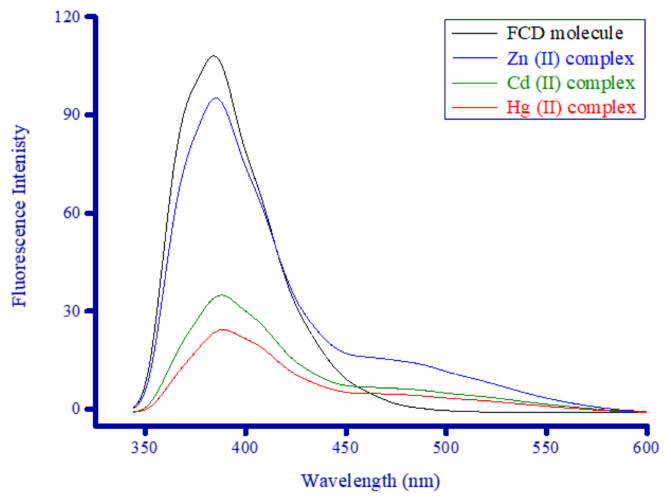
Figure 10. Fluorescence emission spectra of the synthesized metal